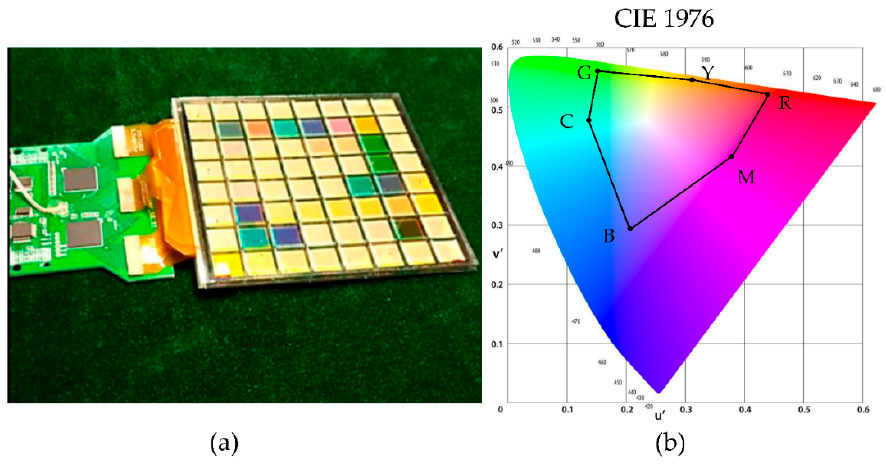
Figure 9. Electrowetting display color gamut demonstration, using scalable fabrication and testing processes. ( a ) A photo of a fabricated and tested three-layer segmented colorful electrowetting display. ( b ) Color gamut of the corresponding colorful segmented electrowetting display in ( a ), measured by an optical colorimeter (63% National Television Standards Committee (NTSC) in International Commission on Illumination (CIE) 1976).